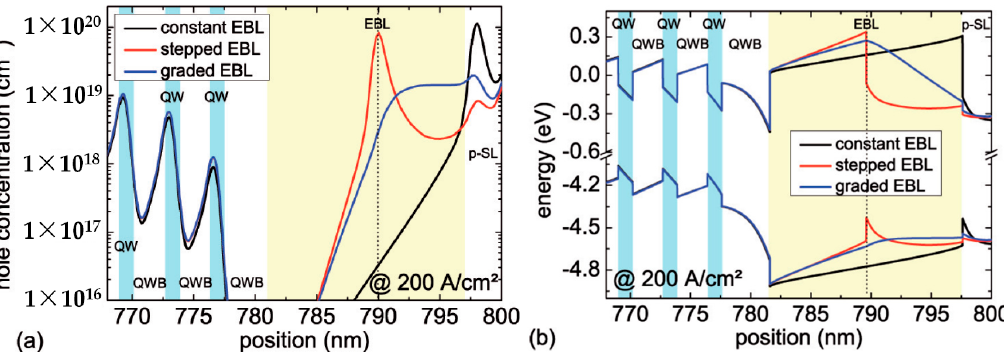
Figure 5 Figure 5. Simulated ( a ) hole concentration and ( b ) conduction- and valence band edge of 310 nm LEDs with different EBL designs (at 200 A/cm 2